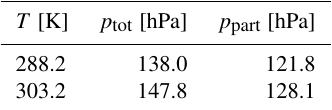
Table 2. Measured variables in the cell with respect to the IFS125HR spectrometer at Karlsruhe TCCON station.